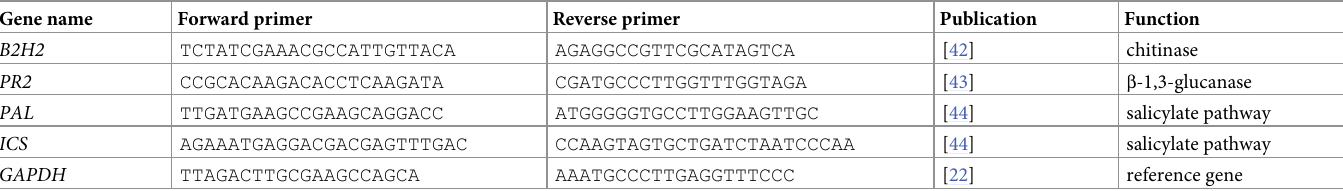
Table 1. Primer pairs used in the study. Names, sequences of forward and reverse primers, publication sources of primer pairs, and gene functions are